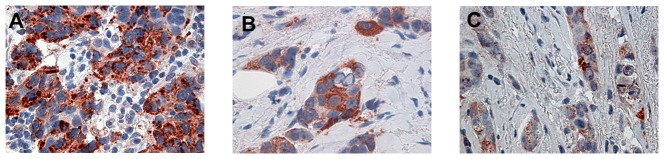
Cytoplasmic immunoreactivity of VEGF in representative tissue samples of breast cancer.(A) and (B) show VEGF overexpression in BRCA1-2 carrier and BRCAX breast cancers respectively; (C) shows low expression of VEGF in sporadic breast cancers.